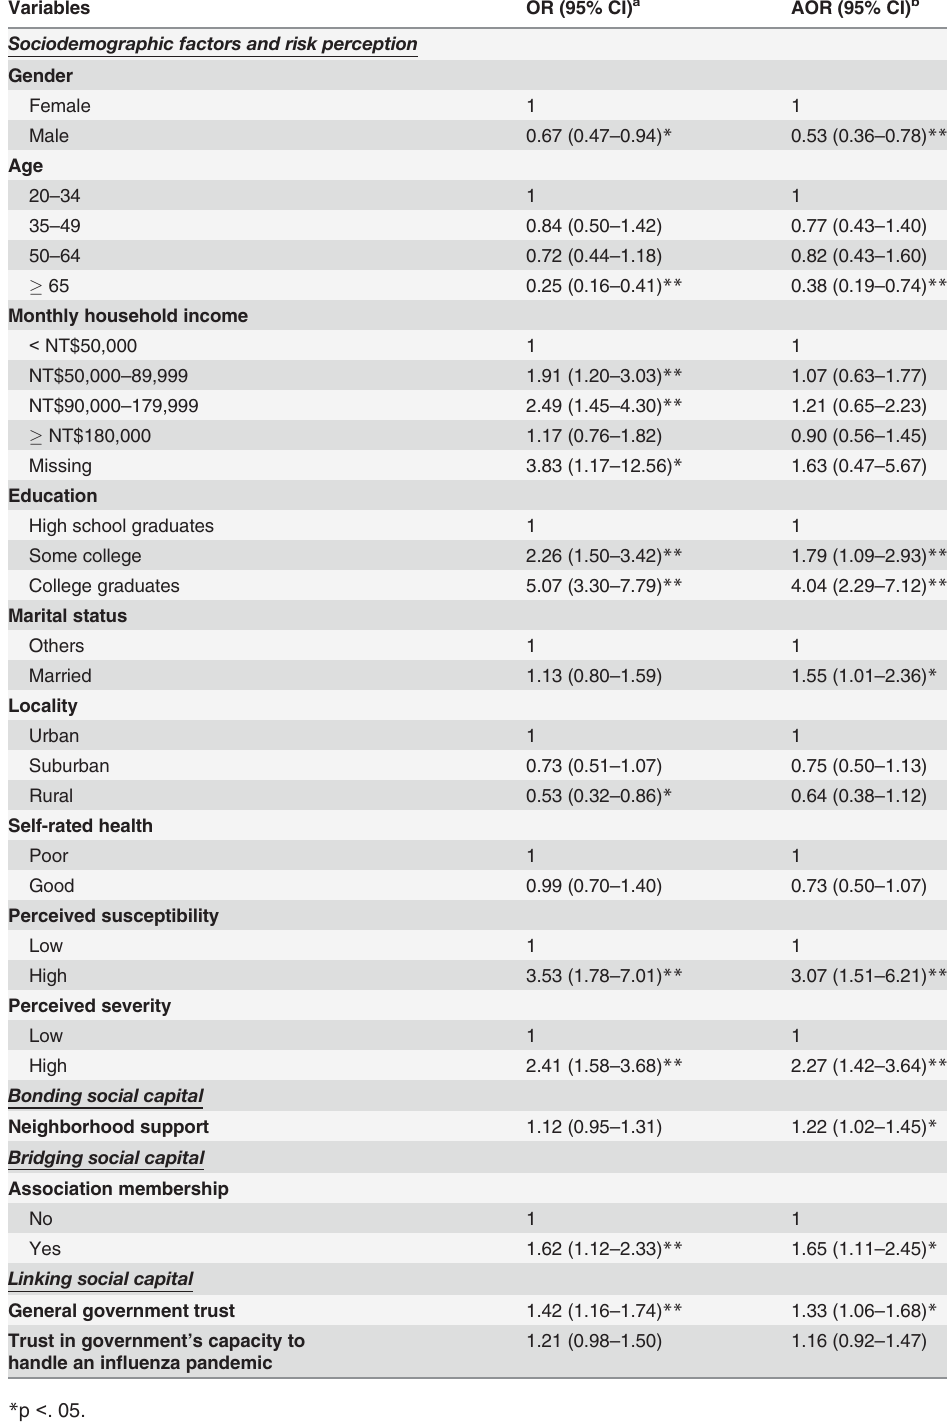
Table 3. Association between social capital, sociodemographic factors, risk perception, and the in- tention to wear a face mask.